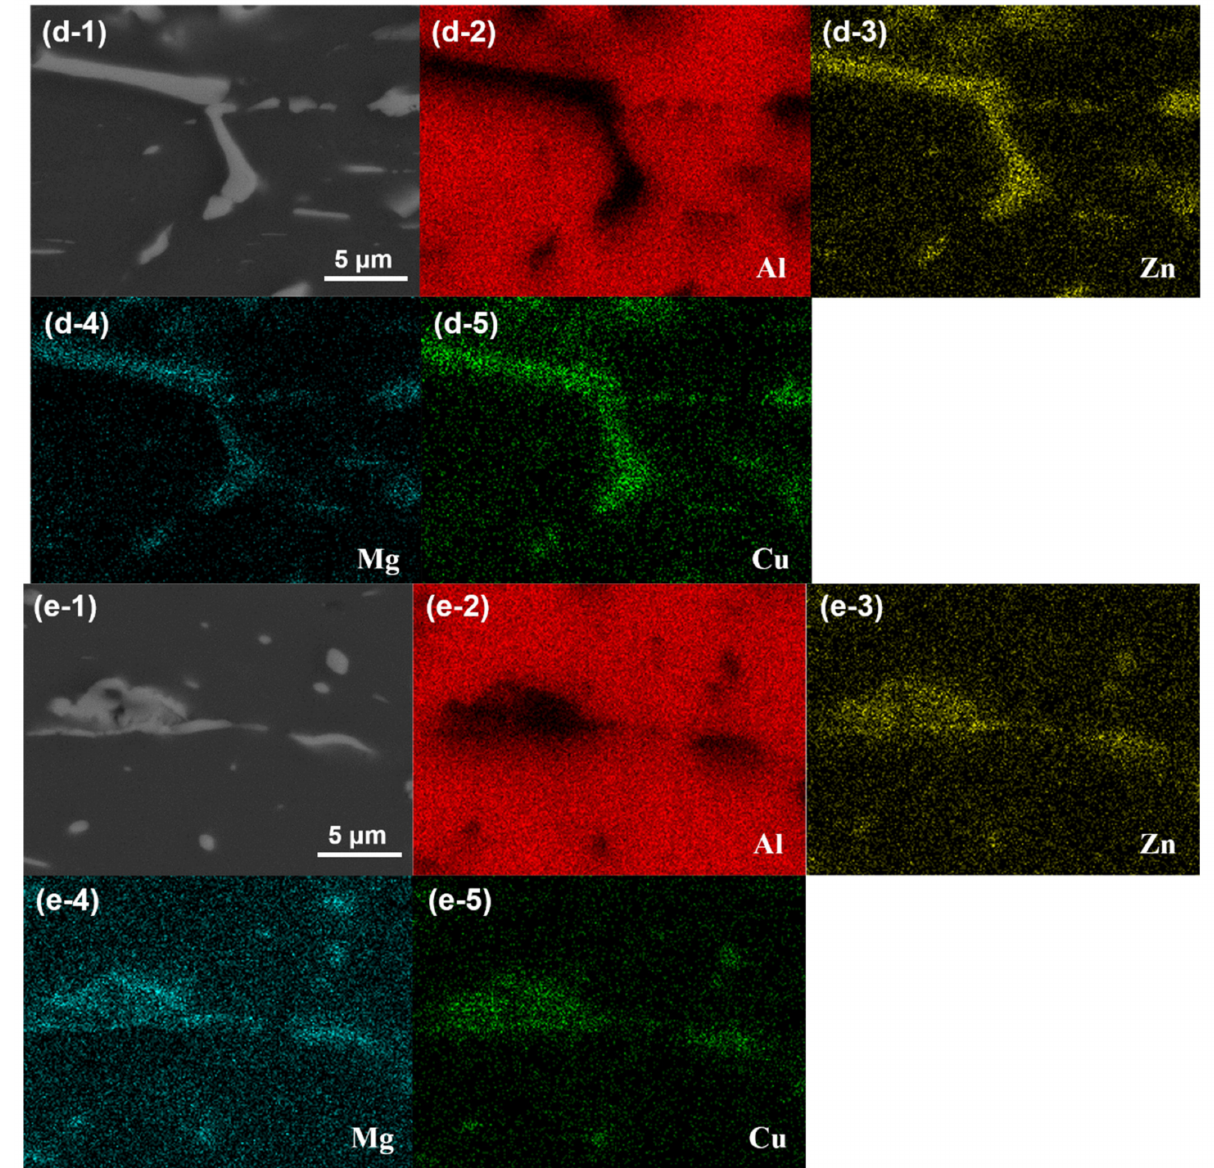
Figure 3. Element plane scanning images of the second phase of spray-deposited 7055 aluminum alloy under hot compression conditions of 450 ◦ C/0.001 s − 1 ( a ), 450 ◦ C/5 s − 1 ( b ), 400 ◦ C/0.1 s − 1 ( c ), 300 ◦ C/0.001 s − 1 ( d ) and 300 ◦ C/5 s − 1 ( e ). The XRD patterns of the spray-deposited specimen and the one hot compressed under 450 ◦ C/0.001s − 1 are shown in Figure 4. It is depicted that the AlZnMgCu phase has the same crystal structure as MgZn 2 [23]. Based on EDS, we know the second phase also contains Al and Cu. So, the AlZnMgCu phase can also be defined as the Mg (Zn,Cu,Al) 2 phase [24]. Besides, the AlZnMgCu phase or Mg (Zn,Cu,Al) 2 phase decreases with the increase in the compressed temperature and the decrease in the strain rate, which is consistent with the SEM analysis